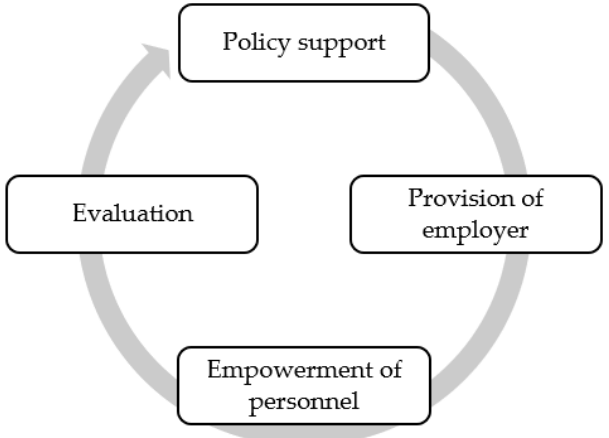
Figure 4. The cycle of limitations to developing occupational health services.